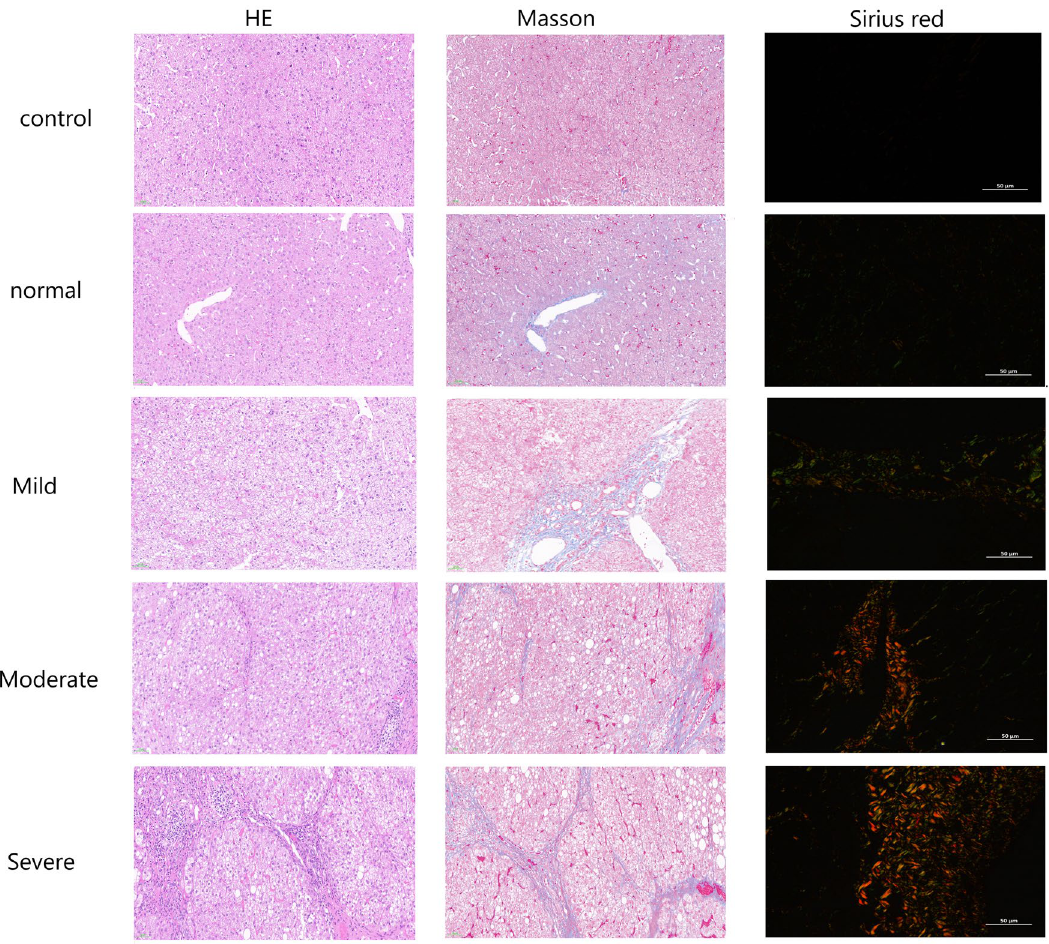
Figure 1. Pathological staining results of different degrees of liver fibrosis and normal liver tissue. There were three different staining results, HE staining, Masson staining and Sirius red staining. The control group was the normal liver tissue outside the hepatic hemangioma. Normal group was liver tissue with chronic hepatitis but without liver fibrosis. Mild group was chronic liver disease with mild liver fibrosis. The moderate group was chronic liver disease with moderate liver fibrosis. The severe group was the liver tissue with chronic liver disease and severe hepatic